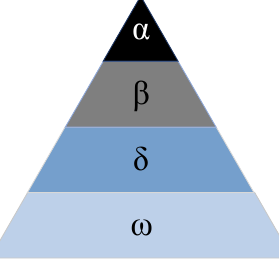
Figure 3. GWO hierarchical structure [27].